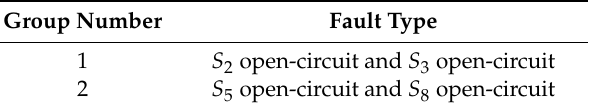
Figure 3. Healthy and eight IGBTs open-circuit output voltage waveforms. Table 1. Similar faults.